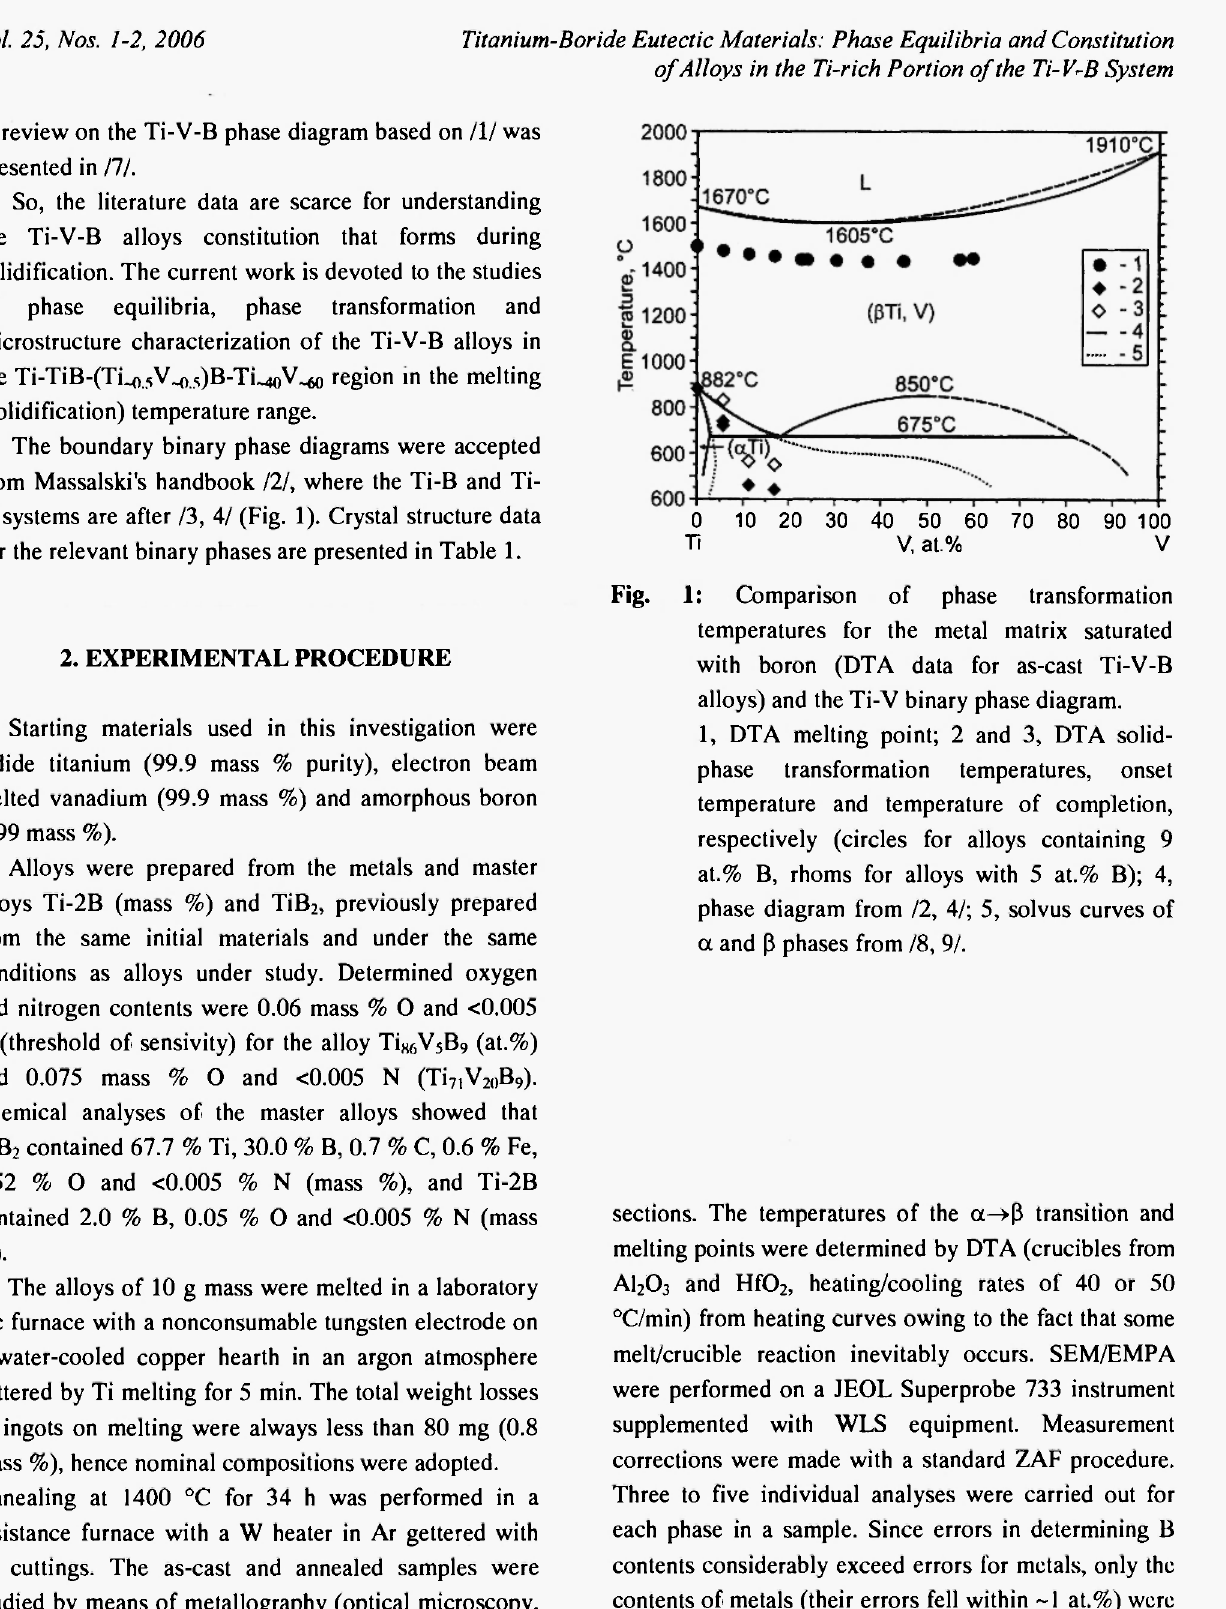
Fig. 1: Comparison of phase transformation temperatures for the metal matrix saturated with boron (DTA data for as-cast Ti-V-B alloys) and the Ti-V binary phase diagram. 1, DTA melting point; 2 and 3, DTA solid- phase transformation temperatures, onset temperature and temperature of completion, respectively (circles for alloys containing 9 at.% B, rhoms for alloys with 5 at.% B); 4, phase diagram from /2, 4/; 5, solvus curves of α and β phases from 18,